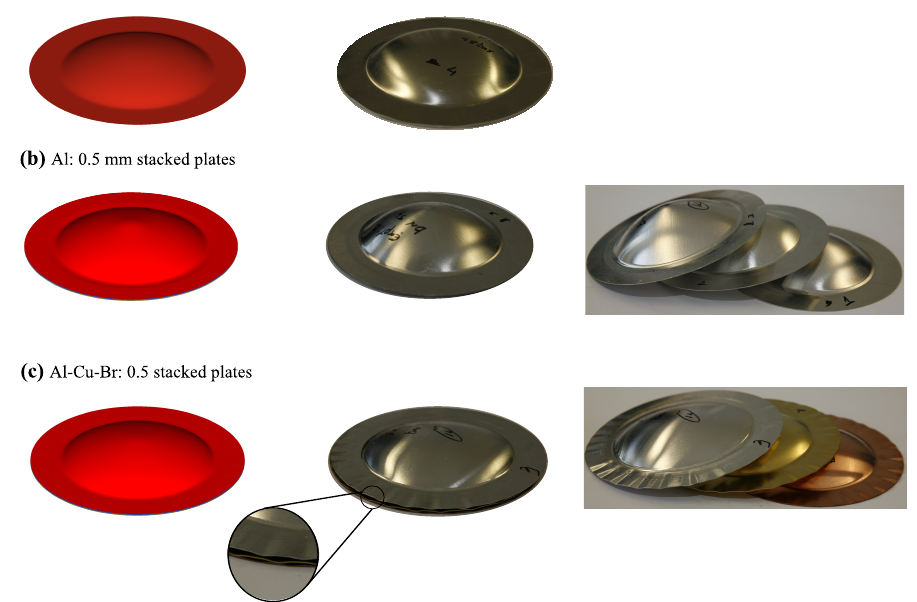
Figure 6. Qualitative comparison of the deformed metal between the experiments and the numerical simulations for ( a ) 1.5 mm single plate of Al, ( b ) 0.5 mm stacked plates of Al and ( c ) 0.5 mm stacked plates of